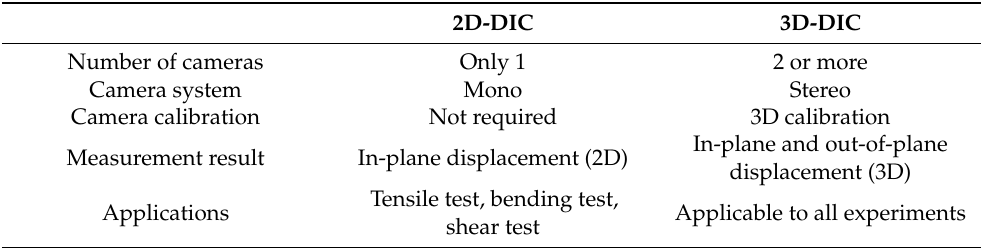
Table 2. Comparison of 2D/3D image correlation systems.